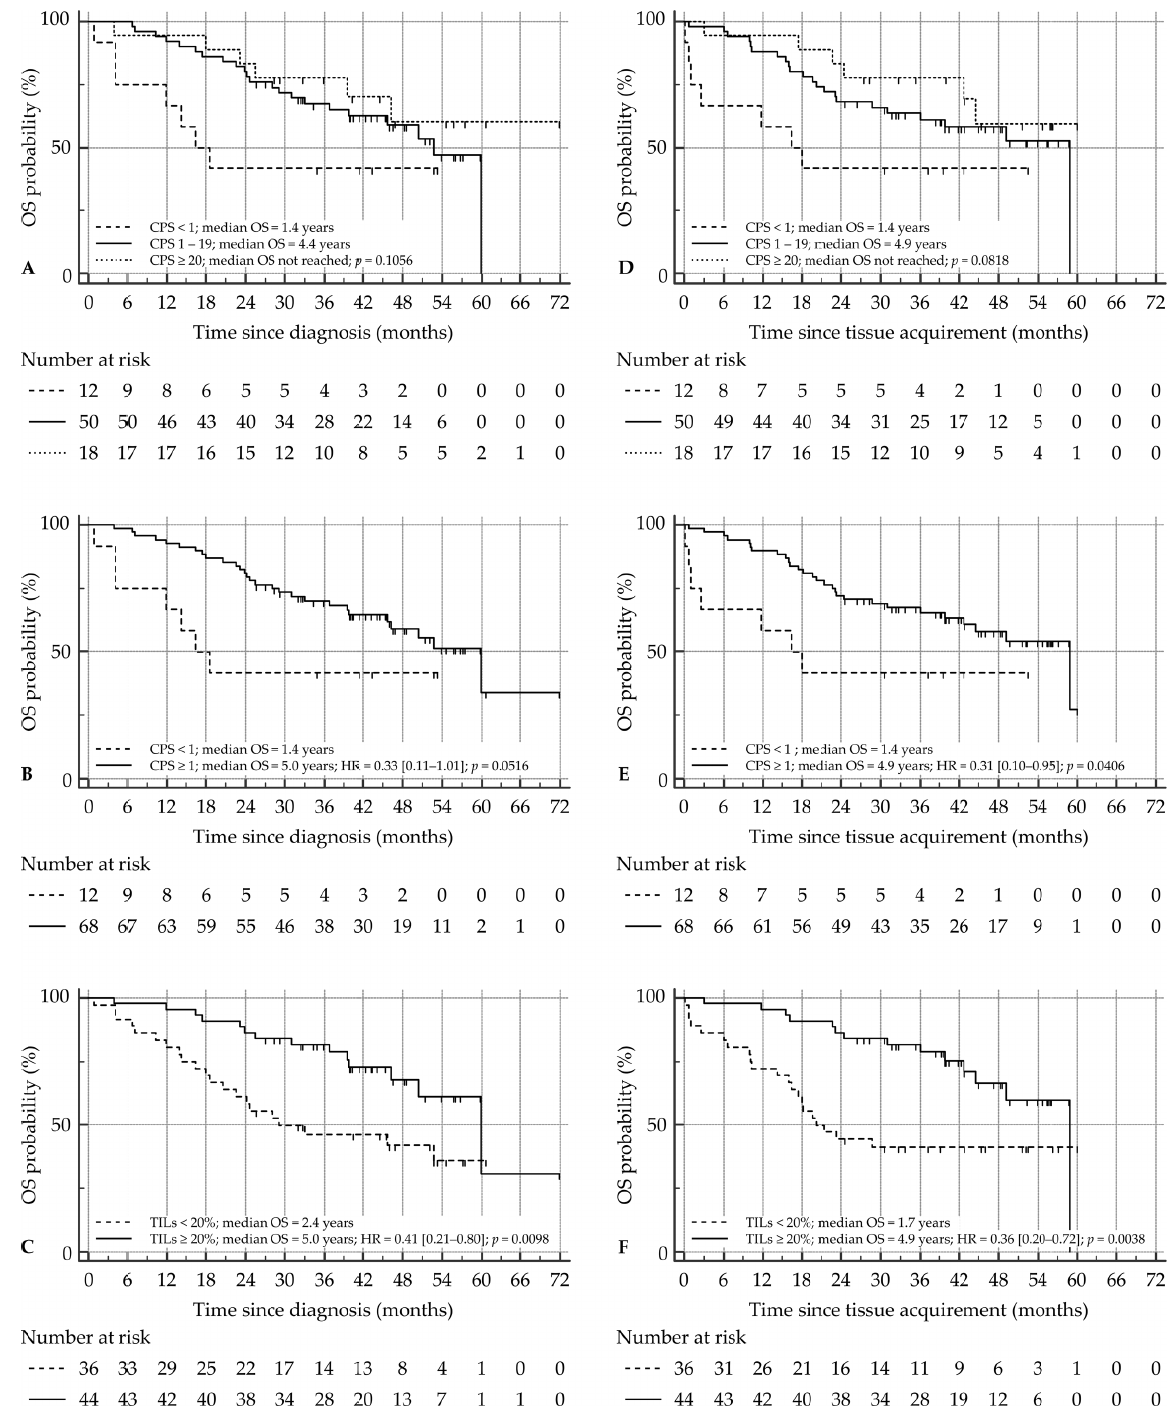
Figure 3. Effect of CPS and TIL count on OS in SCCHN patients. x -axis depicts survival time (in months), y -axis depicts the cumulative OS probability. OS since diagnosis is depicted for ( A ) trichotomous CPS, ( B ) dichotomous CPS, and ( C ) TILs. OS since time of tissue acquirement is depicted for ( D ) trichotomous CPS, ( E ) dichotomous CPS, and ( F ) TILs. Number at risk for each group is indicated beneath each OS curve. CPS, combined positive score; HR, hazard ratio; OS, overall survival; SCCHN, squamous cell carcinoma of the head and neck; TIL, tumor-infiltrating